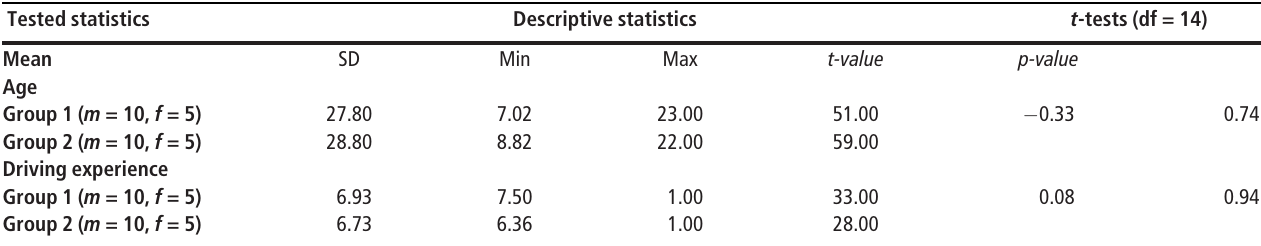
Table 1 Results of t-tests between two